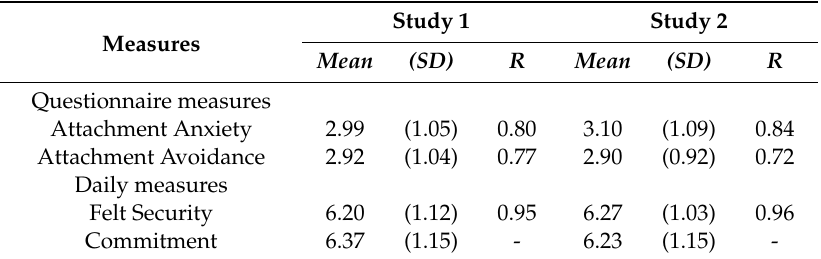
Table 1. Descriptive statistics of all